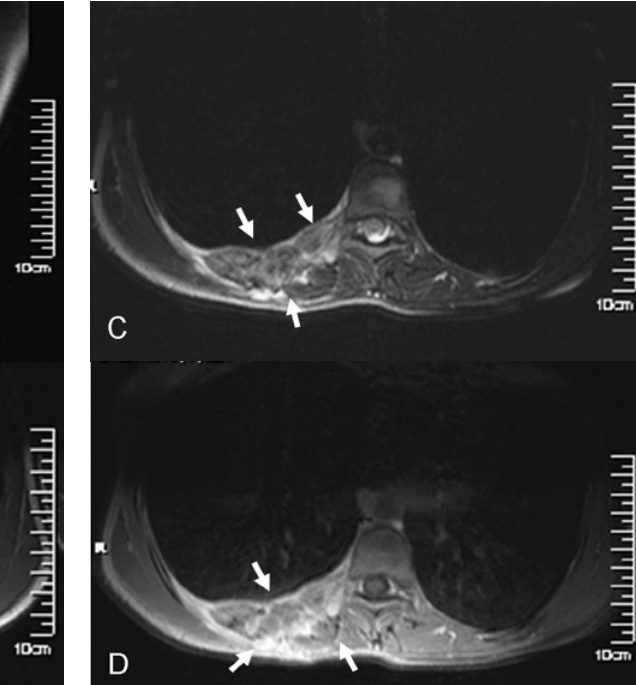
Figure 1. Thoracic wall MR imaging of a 22 year old woman with a mass on the posterior thoracal wall. A, Coronal T1 weighted image shows tumoural lesion destructing posterior part of 9th rib (arrows). B, Axial T1 weighted image demonstrates lesion is isointense to vertebra corpus (arrows). C, T2 weighted axial image shows hyperintense mass with heterogenous hypointense areas denoting the calcification (arrows). D, Postcontrast T1 weighted images shows heterogenous enhancement of the tumour (arrows).